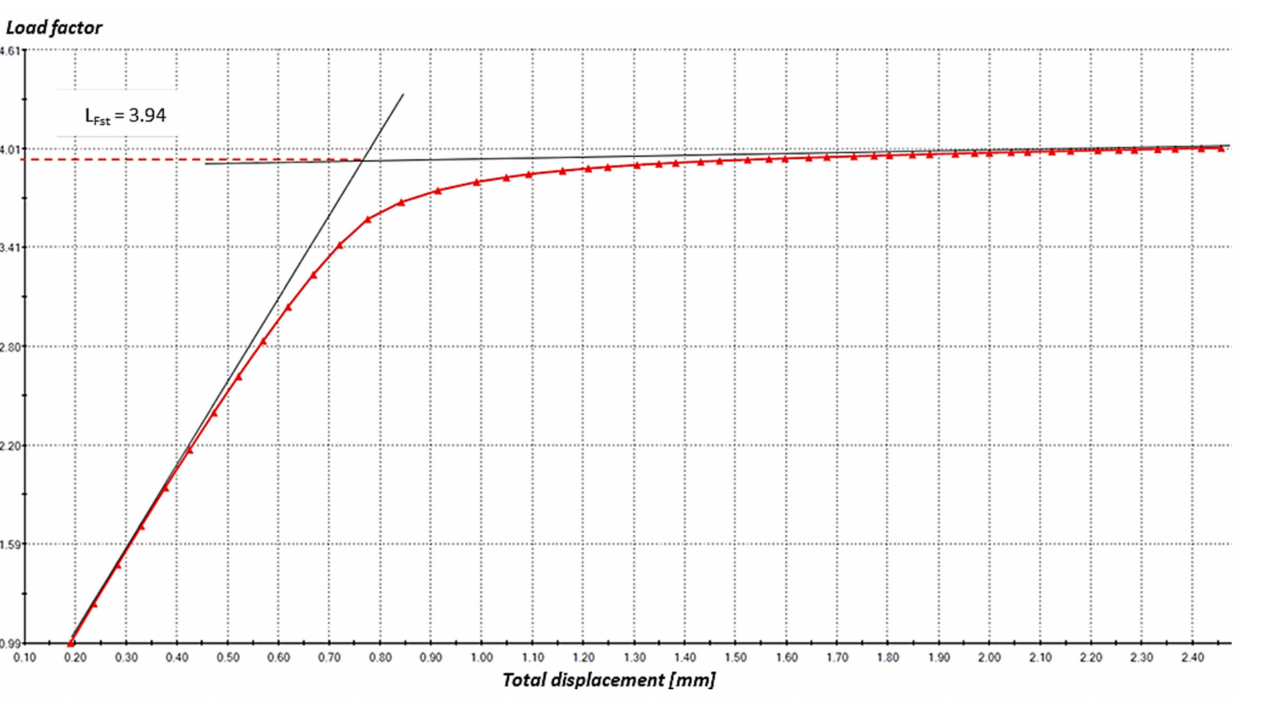
Figure 13. Load characteristics at the node 37 858.